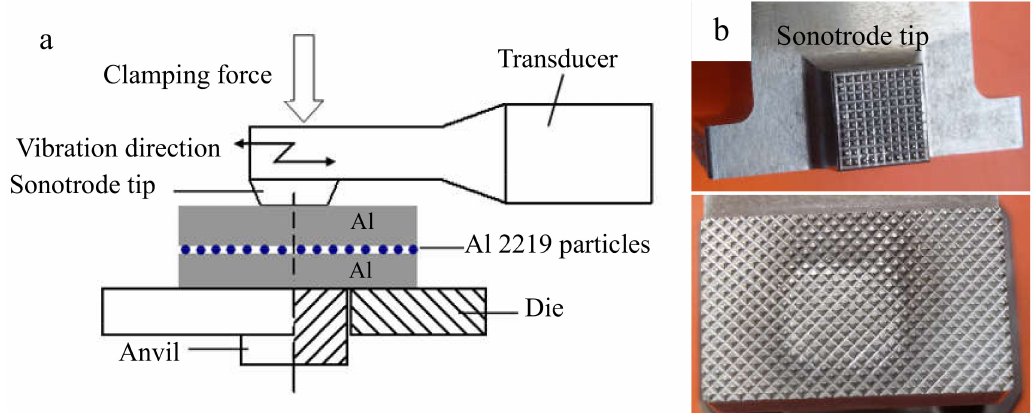
Figure 1. ( a ) Diagram of ultrasonic spot welding and ( b ) detailed knurl patterns of the sonotrode tip (top) and anvil (bottom).